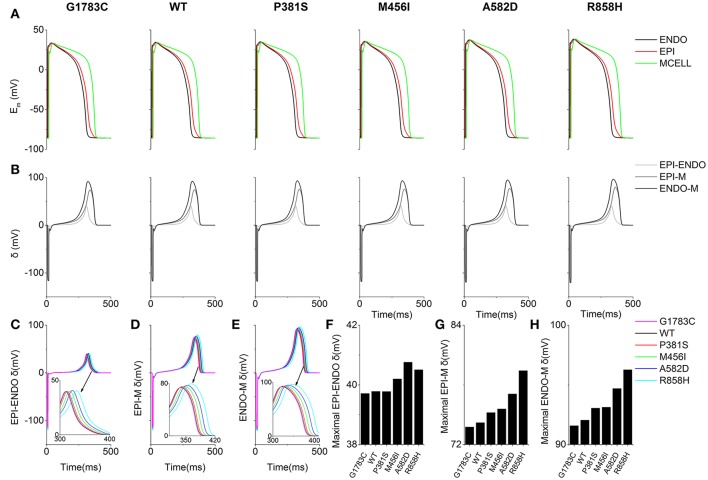
Membrane potential heterogeneity (δ) for EPI-ENDO (between epicaridal and endocardial cells), EPI-M (between epicaridal and midmyocardial cells) and ENDO-M (between endocaridal and midmyocardial cells) in a one-dimensional (1D) transmural ventricular cable. (A) Endocardial (ENDO, Black), epicardial (EPI, Red), and midmyocardial (MCELL, Green) membrane potentials (Em) for the G1783C, wild-type (WT), P381S, M456I, A582D and R858H conditions. (B) EPI-ENDO (Light Gray), EPI-M (Gray) and ENDO-M δ (Dark Gray). (C–E) Superimposed EPI-ENDO, EPI-M and ENDO-M δ. (F–H) Absolute maximum EPI-ENDO, EPI-M, and ENDO-M δ.